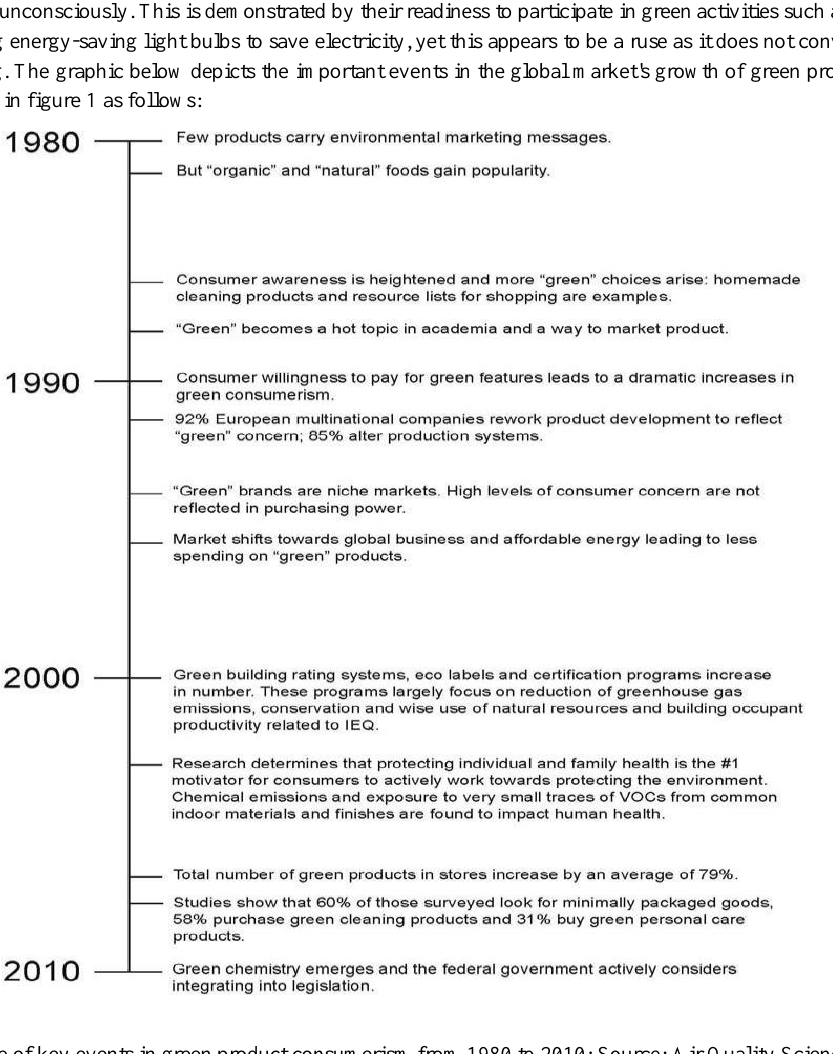
Figure 1: Timeline of key events in green product consumerism from 1980 to 2010; Source: Air Quality Sciences (2010) Consumption and Adoption of green